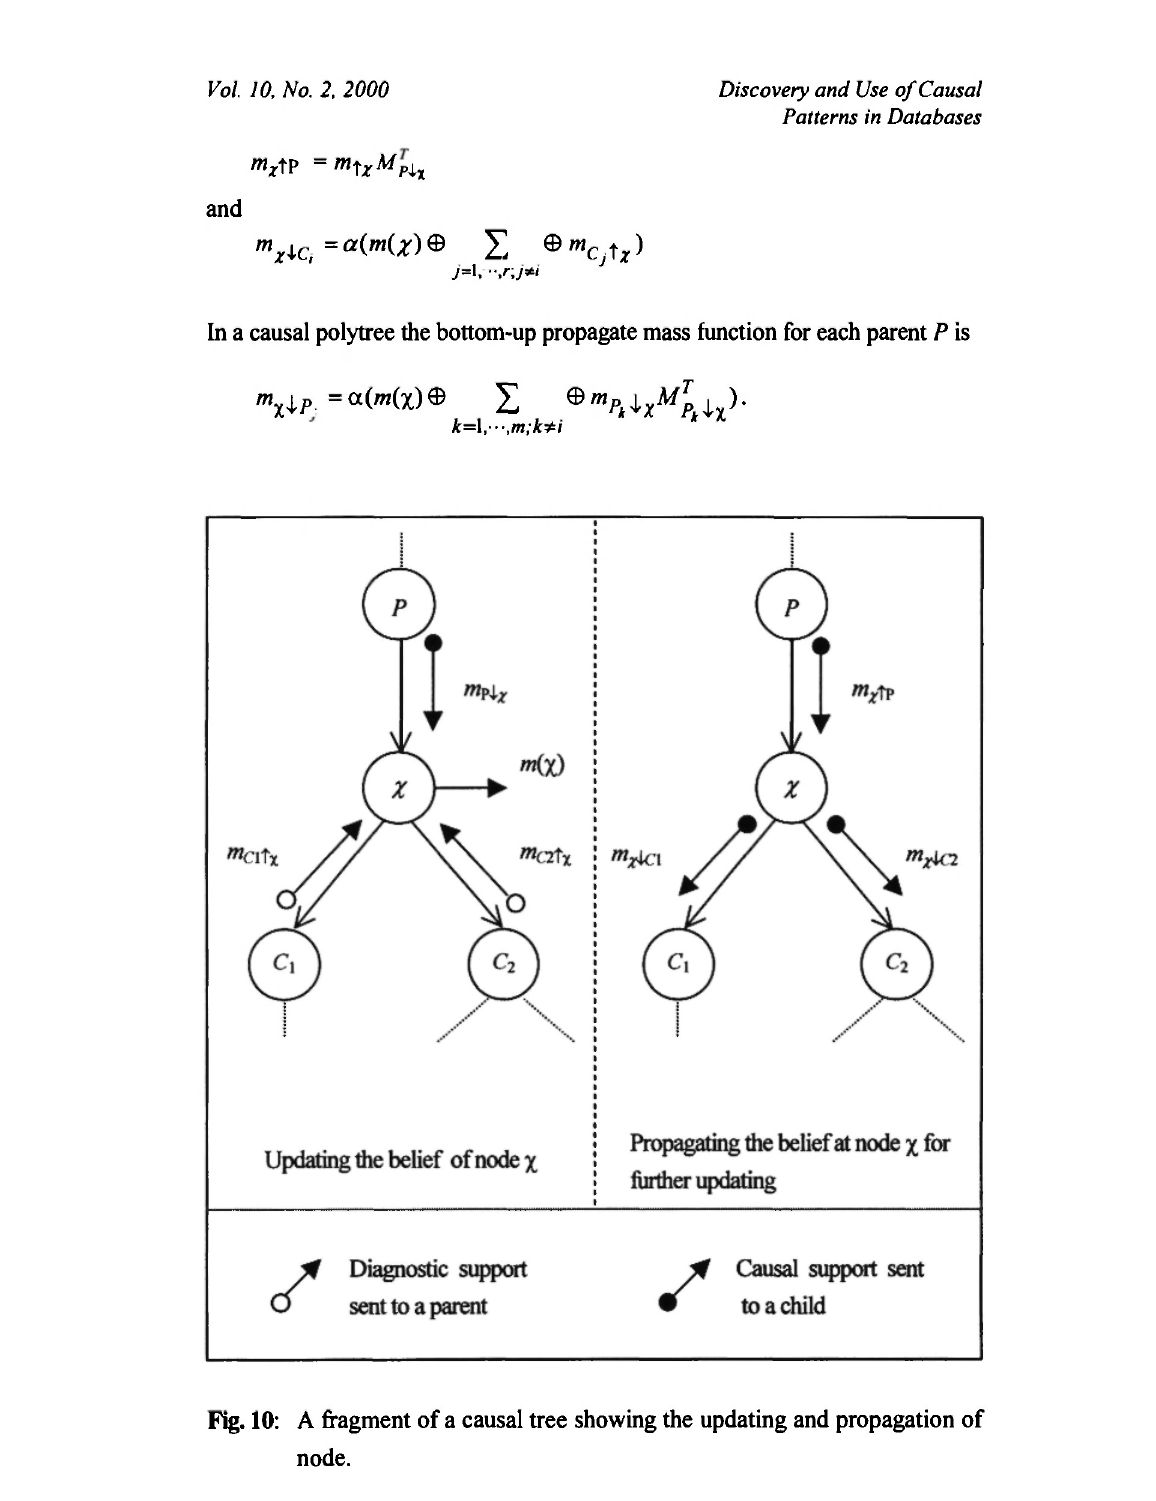
Fig. 10: A fragment of a causal tree showing the updating and propagation of